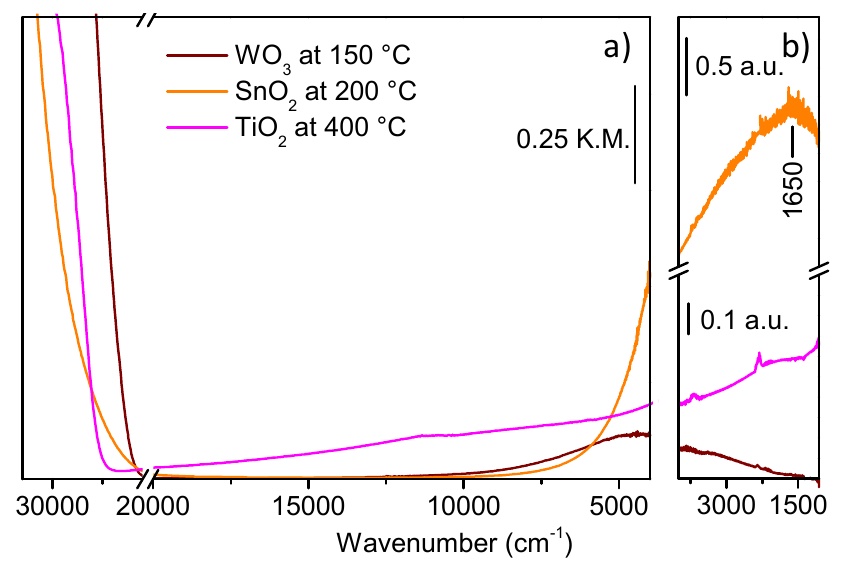
Figure 2. UV–Vis–NIR ( a ) and medium IR ( b ) spectra of: (i) WO 3 and SnO 2 during interaction with CO/O 2 (1:5, pCO = 5 mbar) mixture at the temperature of the maximum intensity reached by the main electronic absorption; (ii) TiO 2 during interaction with CO (20 mbar) at 400 °C.